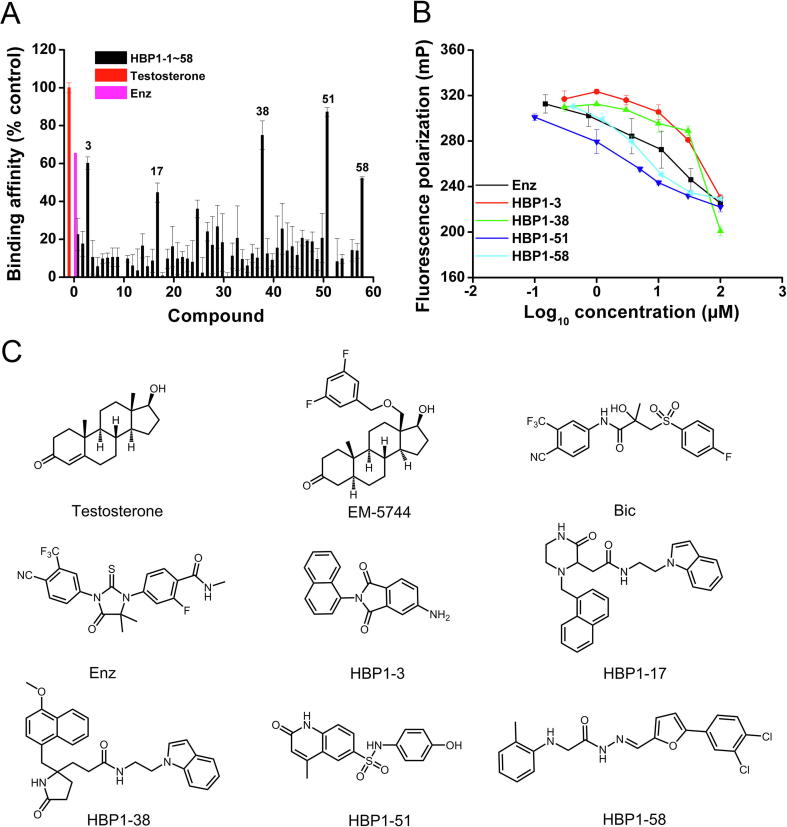
Competitive binding assay of the 58 compounds identified through VSA. Relative AR binding affinity of the 58 compounds (10 µM) analyzed using PolarScreen™ AR Competitor Assay using DHT as control. The numbers at X axis represent the numerical codes of the identified compounds; e.g., 10 represents HBP1-10. The AR binding affinity of DHT was set as 100%. B. Four AR favorable compounds HBP1-3, HBP1-38, HBP1-51, and HBP1-58 were evaluated under various concentrations for their precise binding affinity with Enz as control. Standard errors were derived from at least triplicate assays. C. Structures of HBP1-3, HBP1-17, HBP1-38, HBP1-51, and HBP1-58, and four known AR ligands tested in this study. These include testosterone (endogenous androgen), EM-5744 (reported AR agonist), Bic (marketed AR antagonist), and Enz (marketed AR antagonist). DHT, dihydrotestosterone; Bic, bicalutamide; Enz, enzalutamide.